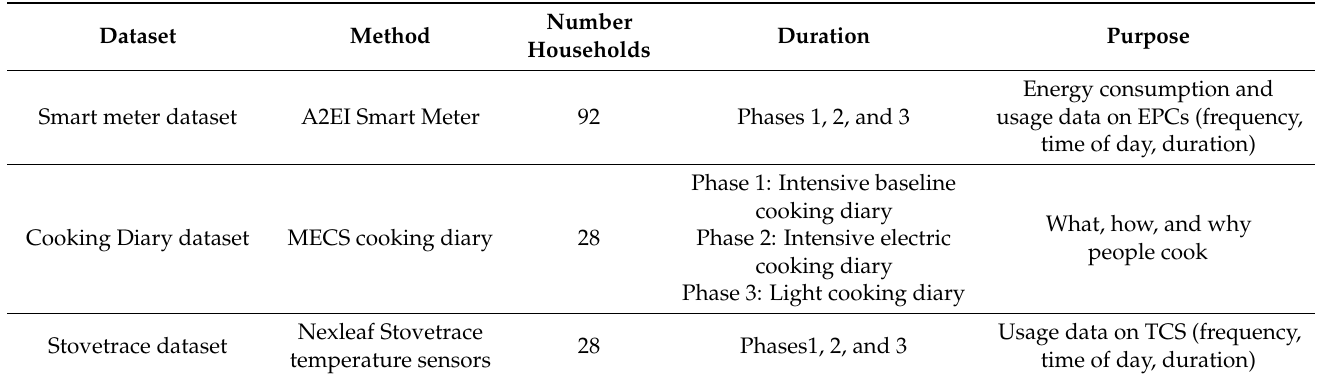
Table 3. Summary of